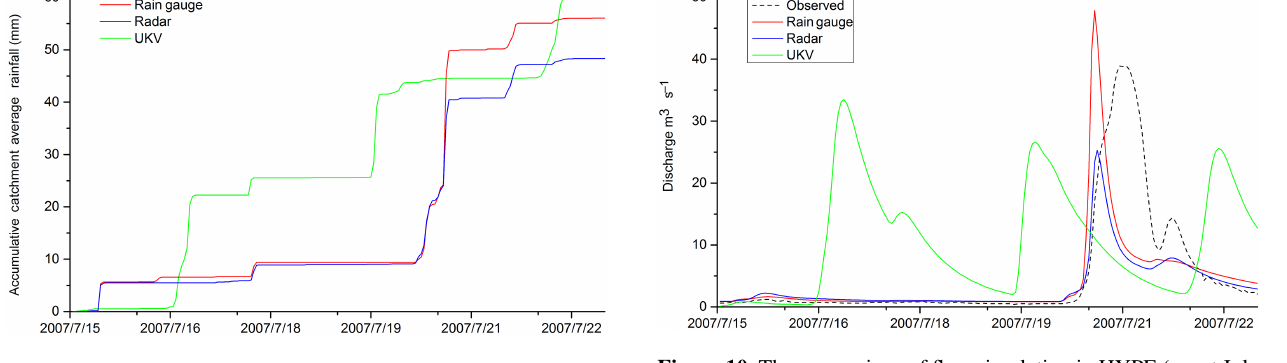
Figure 9. The comparison of accumulative catchment average rain- fall (event July 2007).